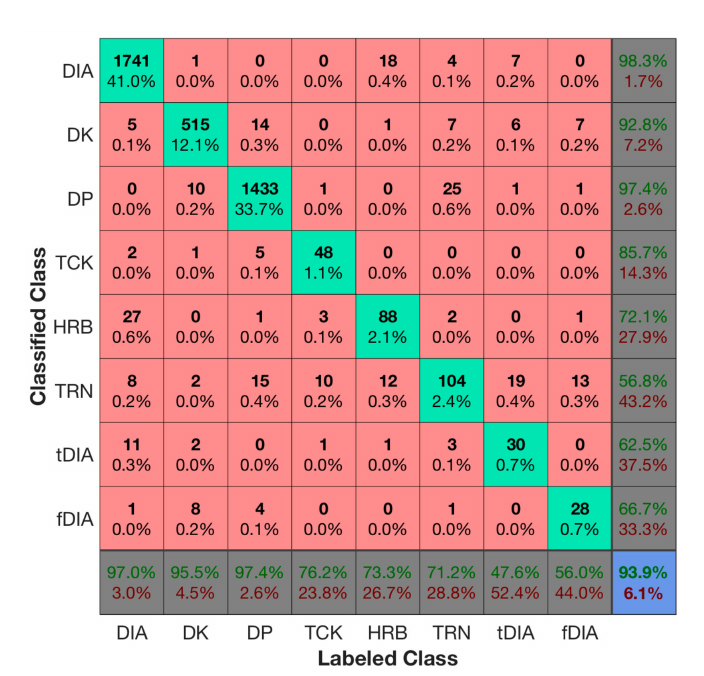
Figure 5. A combined confusion matrix for the all the test datasets. We can, for example, observe that the overall accuracy was 93.9% (lower right value), DP had the best sensitivity (lower row) of 97.4% and DIA had the best precision (rightmost column) of 98.3%. Also, fDIA had the worst sensitivity of 47.6%, and TRN had the worst precision of